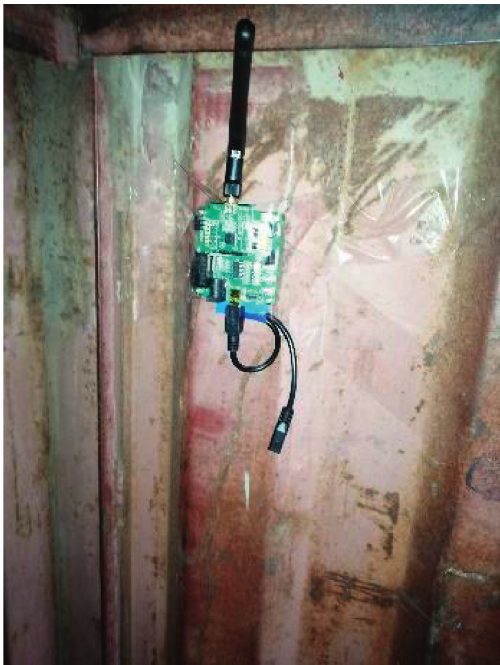
Figure 11: Front anchor node in the carriage.